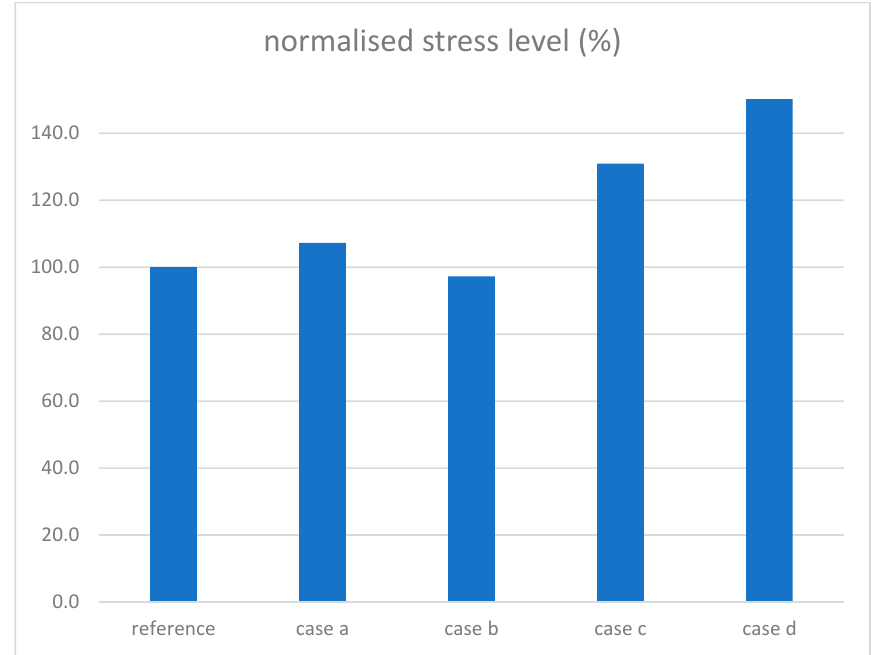
Figure 7. Normalized maximum failure index vs. mesh refinement level: 1st chordwise split ( a ), 1st spanwise split ( b ), 2nd chordwise split ( c ), 2nd spanwise split ( d ); normalization reference: maximum stress computed on the distribution reported in Figure 4 (RL).